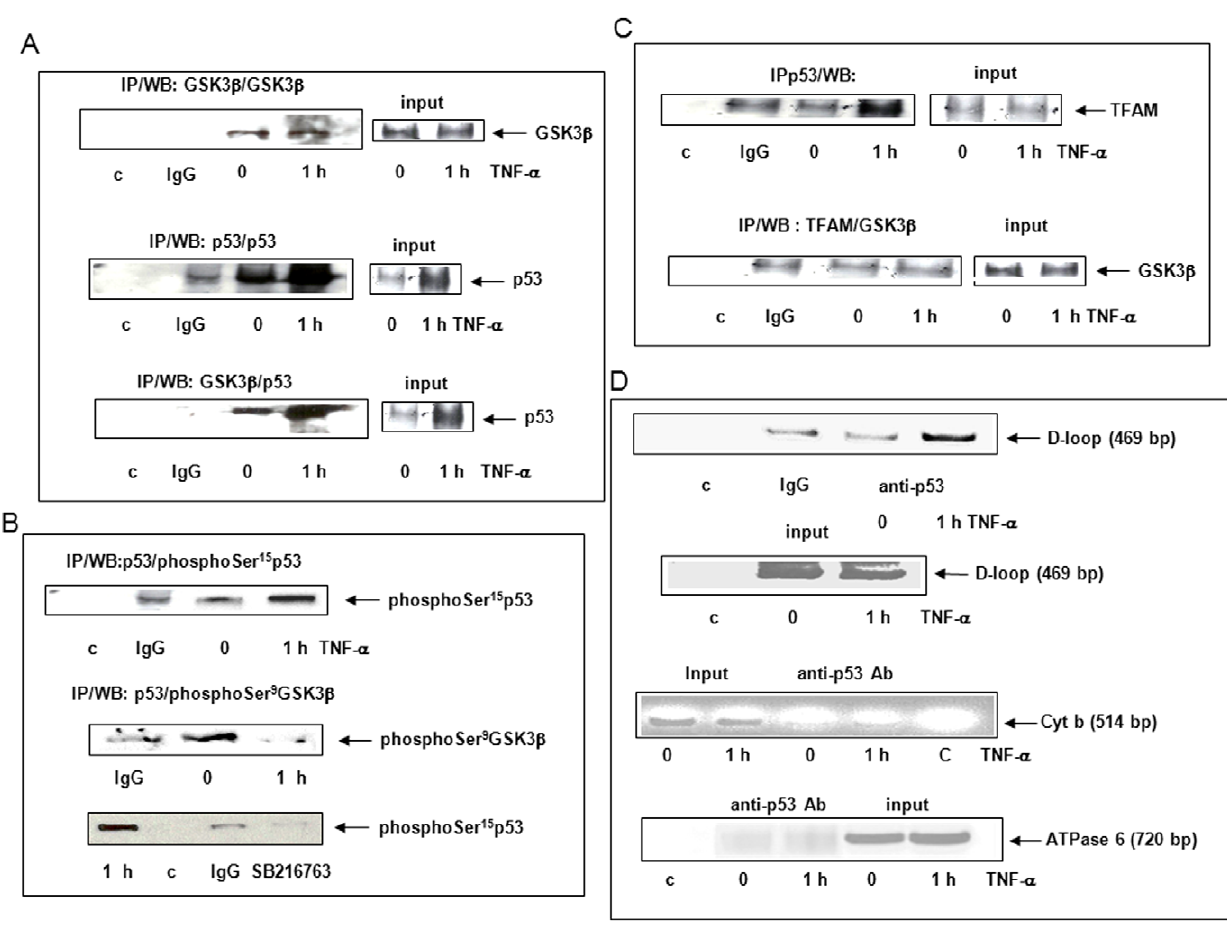
Figure 5. TNF- a induced p53 interaction to GSK3 b , TFAM and D-loop. Cells were treated for 0 (zero-time control) or 1 h with 30 ng/ml TNF- a . Mitochondrial fractions were isolated and co-immunoprecipitated or not (input) with GSK3 b , p53 (FL-393) or TFAM polyclonal antibodies, IgG or no antibody was used as a control (c). (A) Western Blots were performed using GSK3 b or p53 (DO1) antibody. (B) Western Blots were performed using phosphoSer 15 p53 or phosphoSer 9 GSK3 b antibody in not pretreated or pretreated cells with GSK3 b inhibitor SB216763. (C) Western Blots were performed using TFAM or GSK3 b antibody. (D) The mtDIP assay was performed with cross-linked DNA prepared from treated cells for 0 (zero-time control) or 1 h with 30 ng/ml TNF- a . Immunoprecipitates were performed without (control, c) or with IgG used as a control or with p53 antibody. PCR were realized on immunoprecipitates or inputs using a primer pair covering D-loop, cytochrome b (cyt b) or ATPase 6 (Figure 5D).